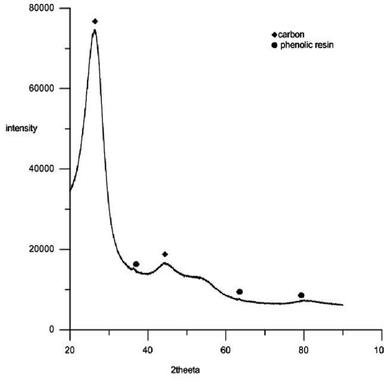
XRD pattern of PC-Ph composite specimen.